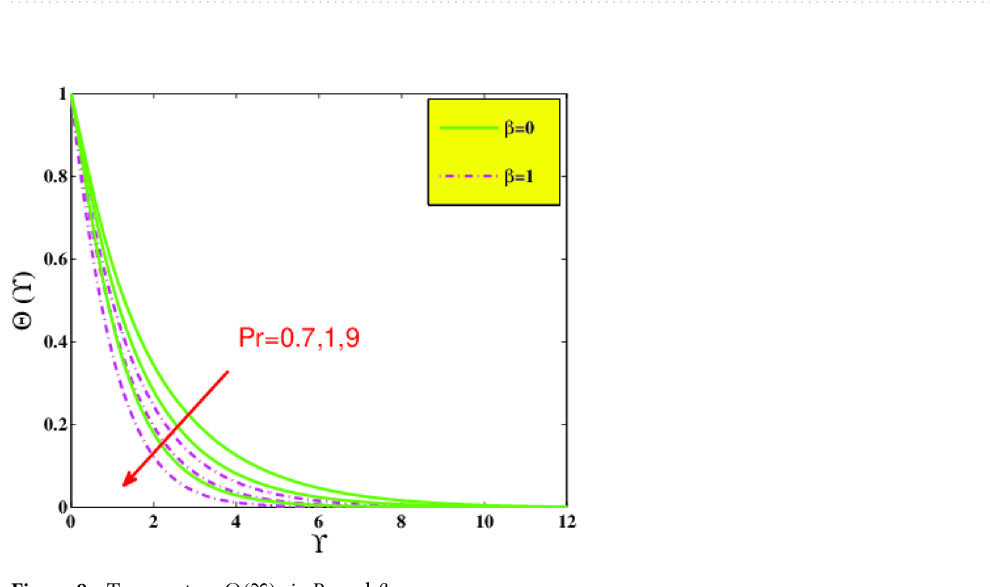
Figure 8. Temperature �(ϒ) via Pr and β